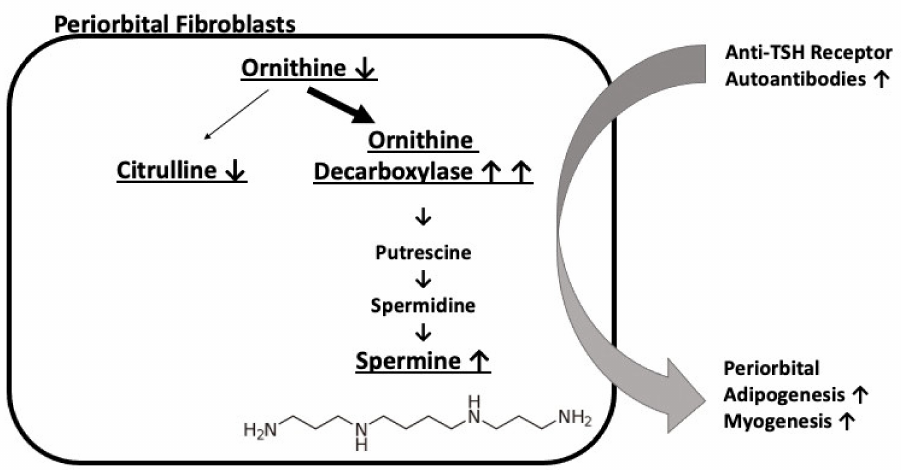
Figure 1. Pathophysiological model suggested by the tear metabolic signature obtained in active versus inactive